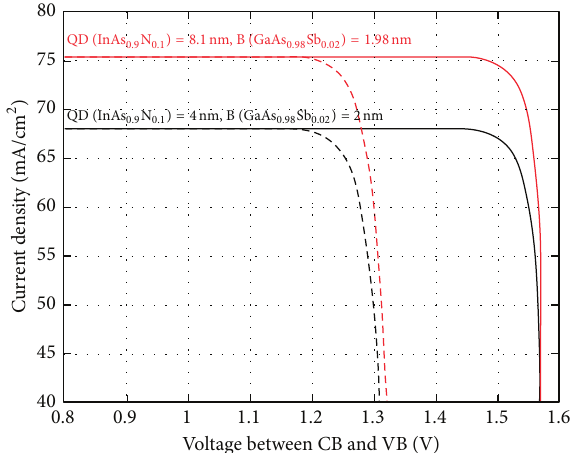
Figure 12: Comparison between current density for QDIBSC at full concentration (solid) and unconcentrated (dash) cases at specified values of quantum dot and barrier widths that give maximum efficiency.